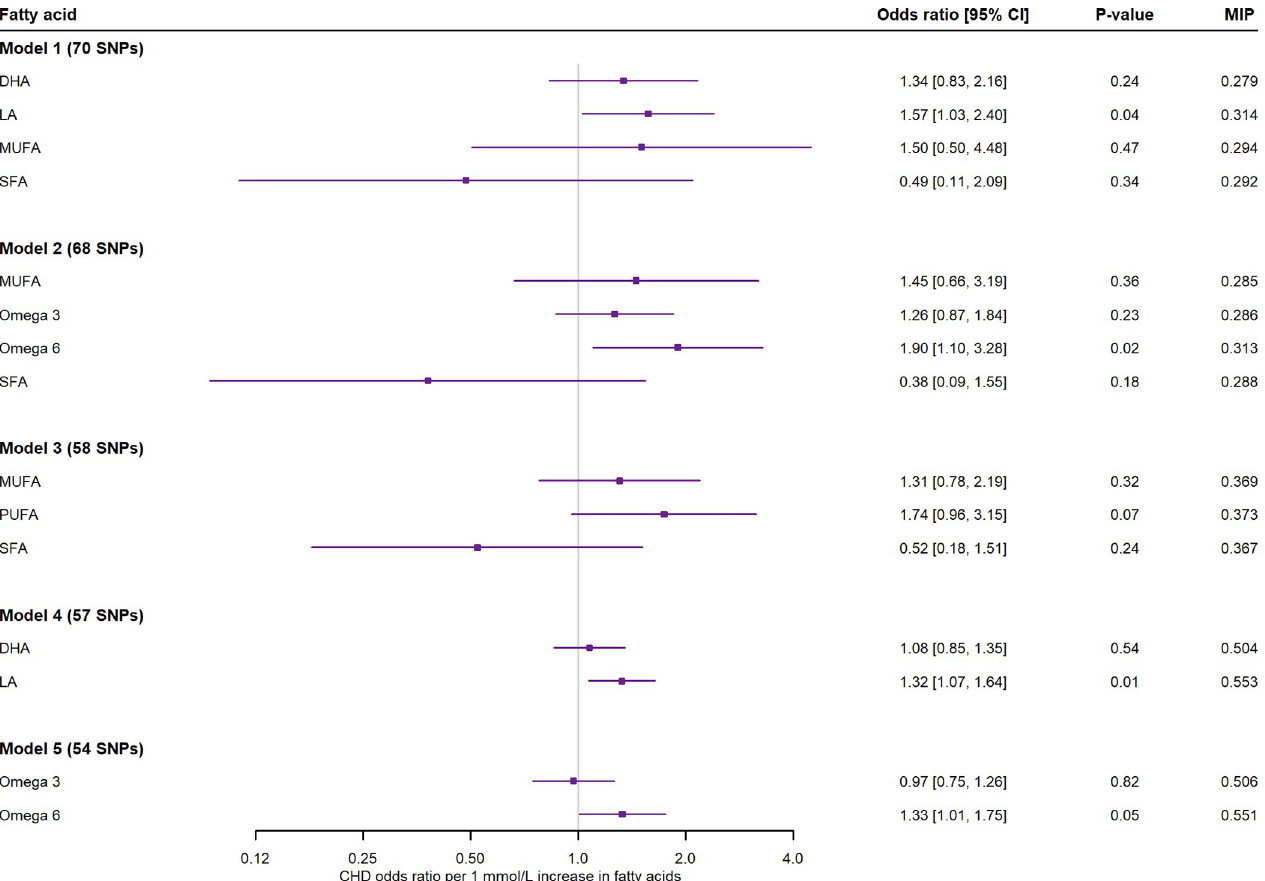
Fig 7. Two-sample multivariable MR effect estimates per 1 mmol/L higher fatty acids on CHD, using UKB betas for fatty acids and betas from CARDIOGRAMplusC4D [22] for CHD. The last column illustrated the MIP per fatty acid (MR-BMA output) to prioritise risk factors on CHD. Five models were fitted to investigate the direct effects of fatty acids. Model 1 considered the simultaneous effects of DHA, LA, MUFA, and SFA; Model 2 the effects of omega-3, omega-6, MUFA, and SFA; Model 3 the effects of PUFA, MUFA, and SFA; Model 4: DHA and LA; and Model 5: omega-3 and omega-6. MIP in the last column. CHD, coronary heart disease; DHA, docosahexaenoic acid; LA, linoleic acid; MIP, marginal inclusion probability; MR, mendelian randomisation; MR-BMA, MR-Bayesian method averaging; MUFA, monounsaturated fatty acid; PUFA, polyunsaturated fatty acid; SFA, saturated fatty acid; UKB, UK